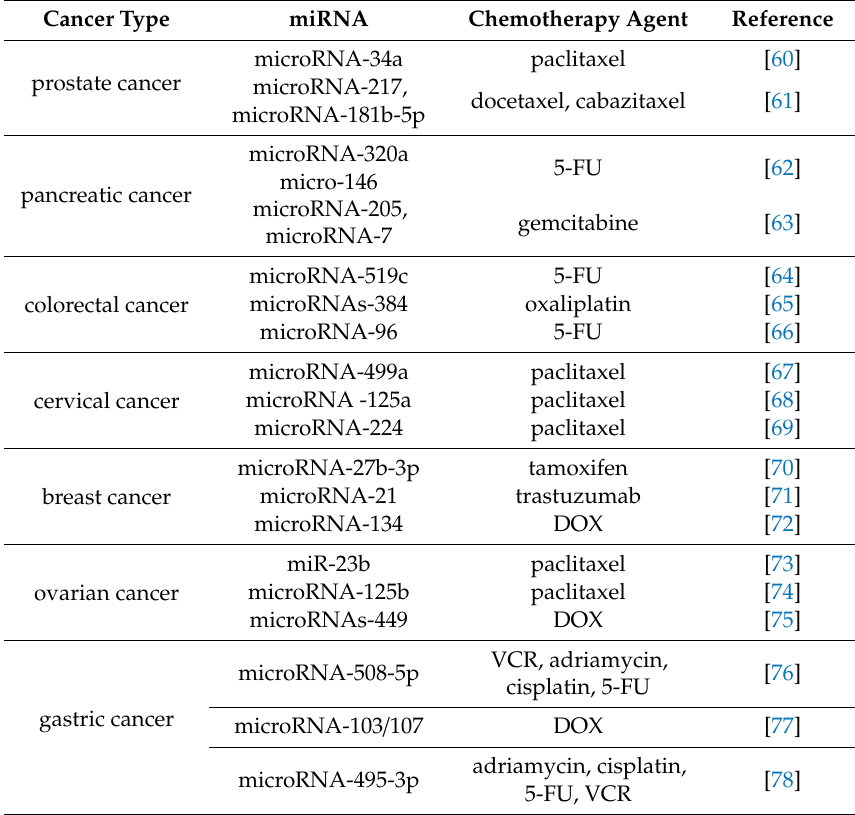
Table 1. Exemplary miRNAs that play an important role in cancer